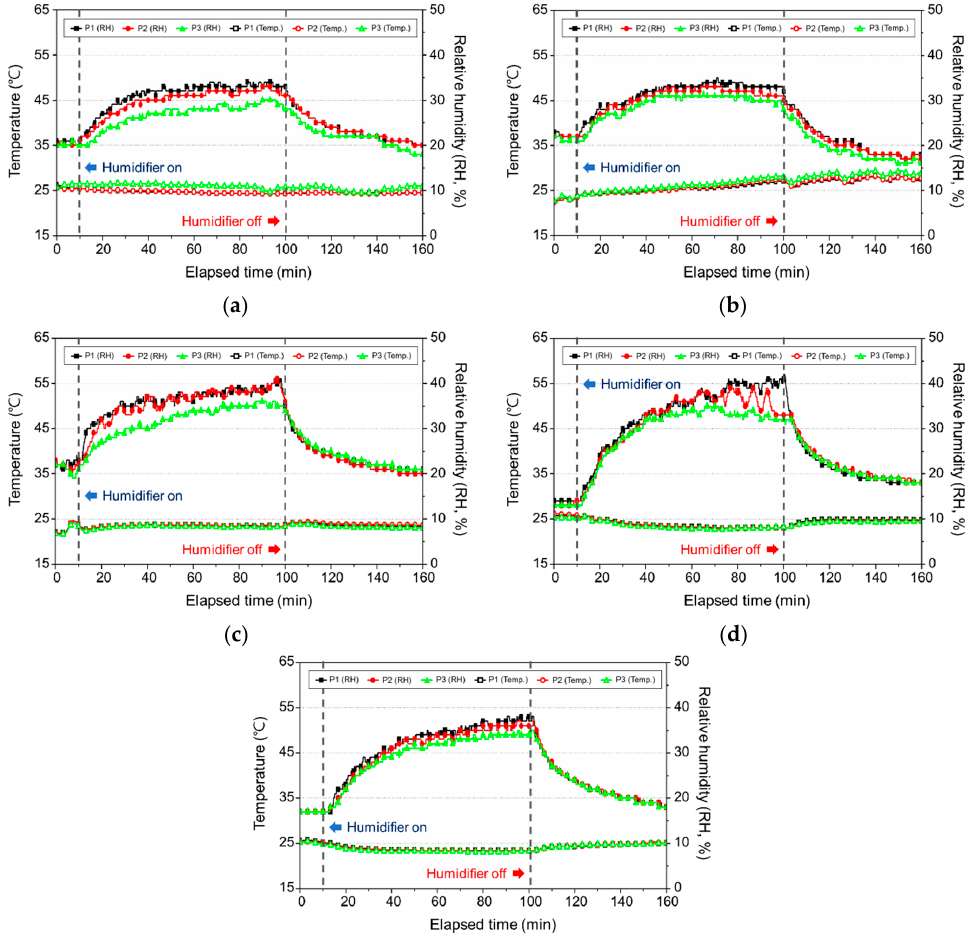
Figure 10. Temperature and relative humidity based on the use of an ultrasonic humidifier for each water type: ( a ) tap water (Seoul); ( b ) tap water (Gwangju); ( c ) mineral water; ( d ) purified water; ( e ) distilled water.